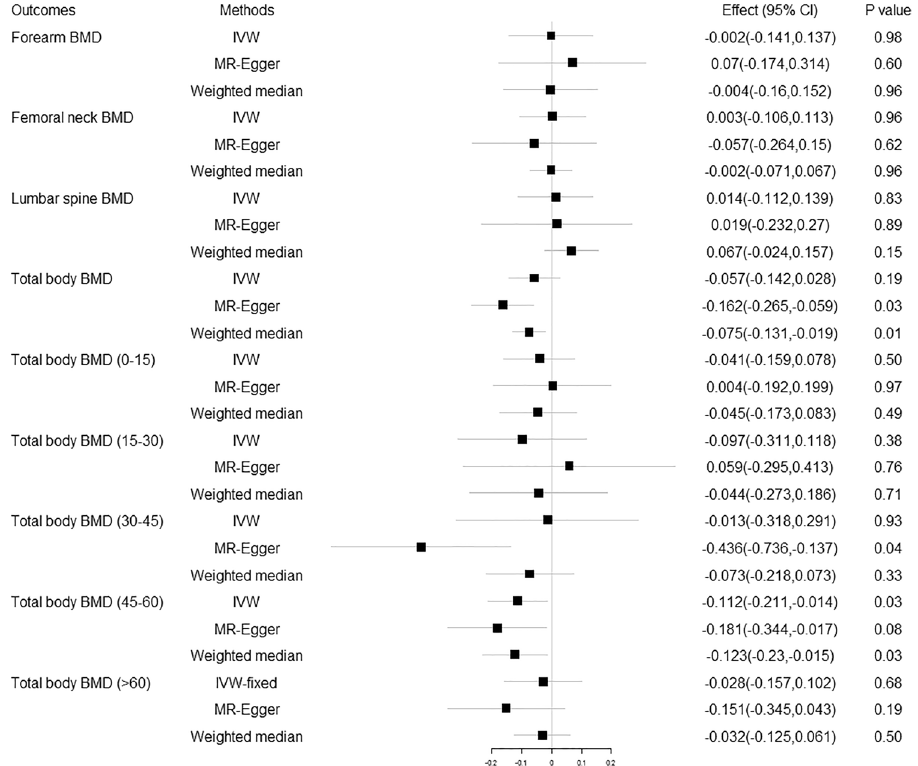
Figure 3. Replication analysis of the causal effect of 25OHD on BMD using SNPs in or near vitamin D related genes as instrumental variables. 25OHD 25-hydroxyvitamin D, BMD bone mineral density, Effect the combined causal effect of 25OHD on BMD, CI confidence interval, IVW inverse variance weighted.